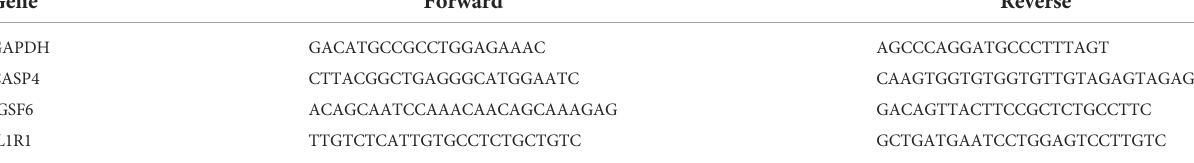
TABLE 1 Primer sequences for